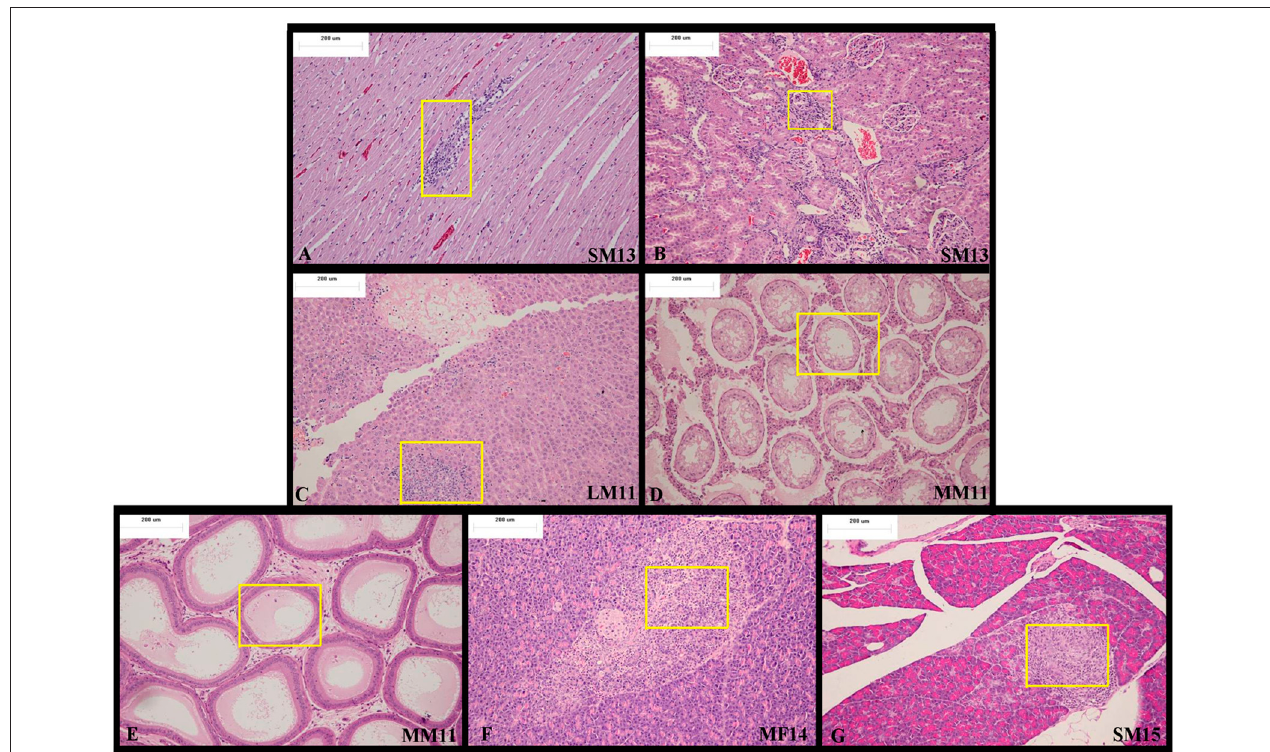
FIGURE 3 | Representative histopathological results of rats at the end of the recovery period (Day 28). At the end of the recovery period, (A) in the apex of the heart, Arctigenin administration resulted in focal necrosis of ventricular wall muscle cells. (B) The interstitial substance of the renal cortex showed lymphocyte focal infiltration. (C) In the liver, the hepatic lobular structure is complete, but there is partial hepatocyte focal necrosis and interstitial lymphocyte infiltration. (D–E) Bilateral epididymis tube showed edema fluid, no spermatocytes, and interstitial chronic inflammatory cell infiltration. (F–G) In the pancreas exocrine gland, focal atrophy and interstitial lymphocytic infiltration were observed. ( × 100